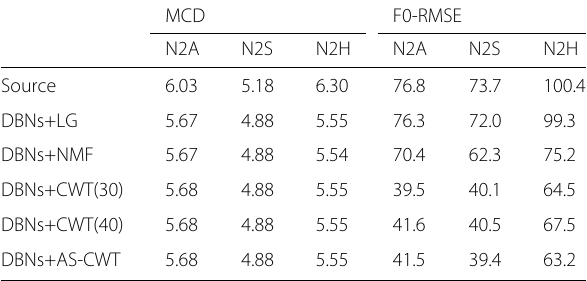
Table 2 MCD and F0-RMSE results for different emotions